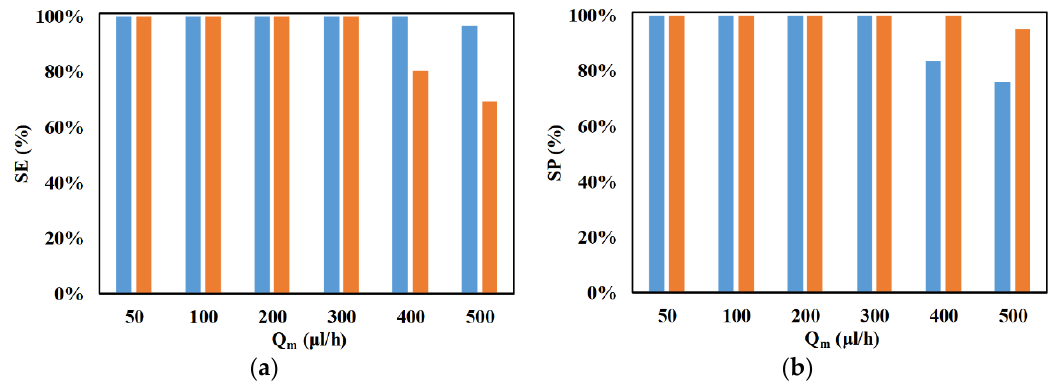
( b ) Figure 12. Variation of SE and SP with volumetric flowrate ( Q m ) for ( a ) (cid:4) 2 µ m and ( b ) (cid:4) 2.25 µ m Figure 12. Variation of SE and SP with volumetric flowrate ( Q m ) for ( a ) ■ 2 μm and ( b ) ■ 2.25 μm ( d f = ( d f = 60 µ m, l f = 120 µ m, d s = 60 µ m, l s = 120 µ m, w f = 6 µ m, w s = 6 µ m, n f = 200, n s = 200, V 1 = 3 V pp , V 2 = 60 μm, l f = 120 μm, d s = 60 μm, l s = 120 μm, w f = 6 μm, w s = 6 μm, n f = 200, n s = 200, V 1 = 3 V pp , V 2 = 15 15 V pp , V 3 = 15 V pp V 4 = 3 V pp , H ch = 50 µ m, W ch = 50 µ m, 0 < W o ,2.25 < 30 µ m, 30 µ m < W o ,2 < 50 µ m, V pp , V 3 = 15 V pp V 4 = 3 V pp , H ch = 50 μm, W ch = 50 μm, 0 < W o,2.25 < 30 μm, 30 μm < W o,2 < 50 μm, N 1 = N 2 N 1 = N 2 = 10 MHz, N 3 = N 4 = N cr ,2 = 473 = 10 MHz, N 3 = N 4 = N cr,2 = 473 kHz).